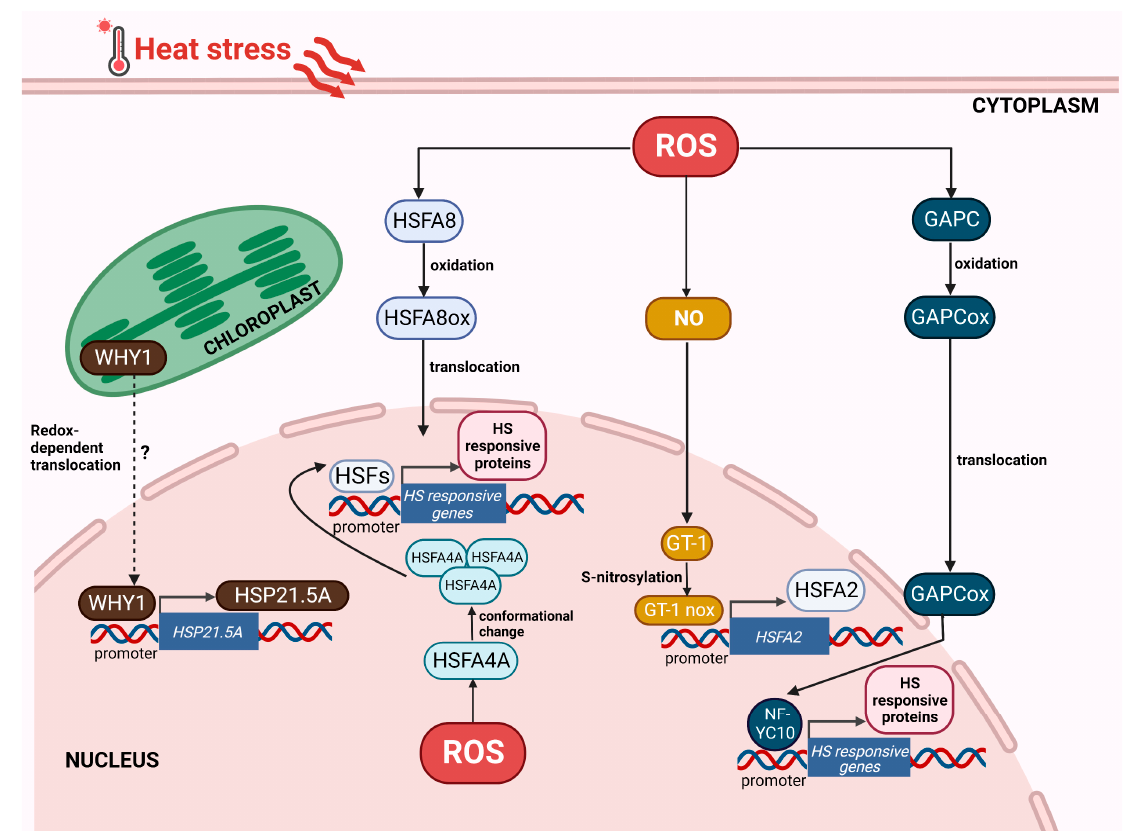
Figure 3. Redox-dependent changes of proteins impacting gene expression in response to heat stress. Heat stress, triggering oxidation of cellular environment, causes redox changes in proteins involved in the induction of heat stress response. The oxidation of HSFA8 and GAPC permits these proteins to move into the nucleus: HSFA8 directly and GAPC by the interaction with NF-YC10 promote the expression of heat stress-responsive (HSR) genes. S-nitrosylation of GT-1, triggered by ROS-dependent NO accumulation, induces the transcription of HsfA2. Nuclear redox oxidation is sensed by HSFA4A, which is stabilized and activated, inducing HSR genes. In the chloroplast, over-reduction in the components of the thylakoid electron transport chain might provoke the redox-dependent translocation of WHY1 in the nucleus, where the protein activates the transcription of HSP21.5A. Abbreviations: HSF, heat shock factor; GAPC, glyceraldehyde-3-phosphate dehydrogenase, cytosolic; NF-YC10, nuclear factor Y, subunit C10; and WHY1, Whirly1. Created with BioRender.com; accessed on 3 february 2023.